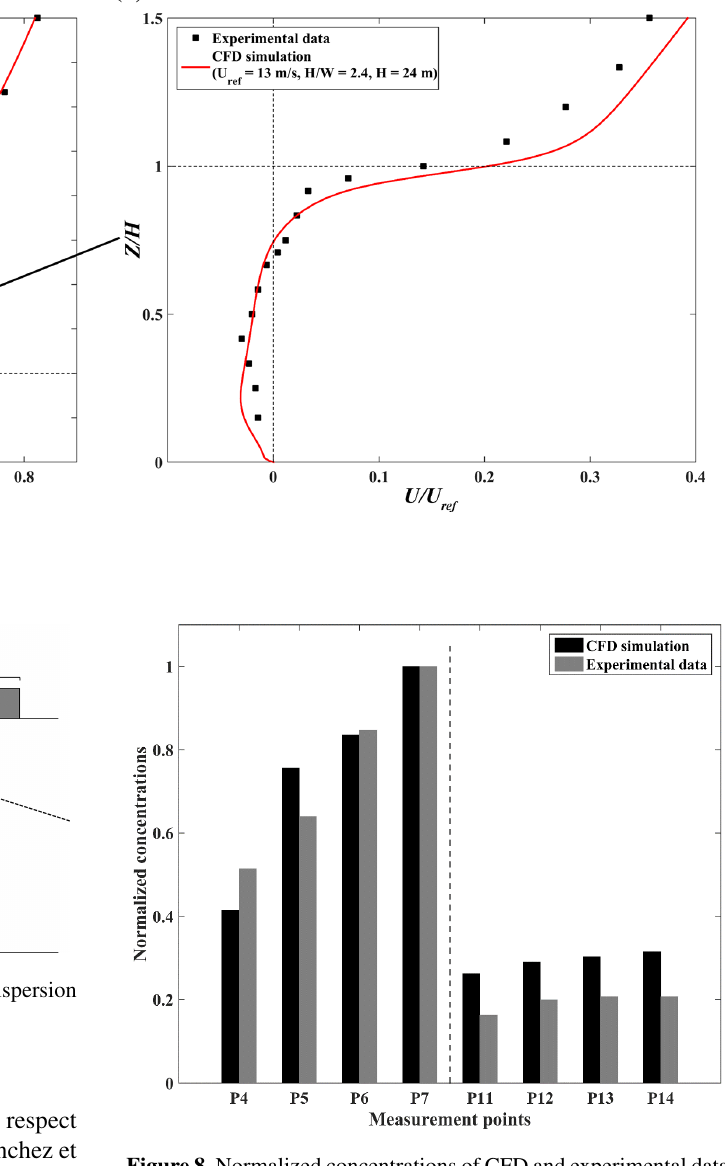
Figure 8. Normalized concentrations of CFD and experimental data at each measurement point in the 2D dispersion